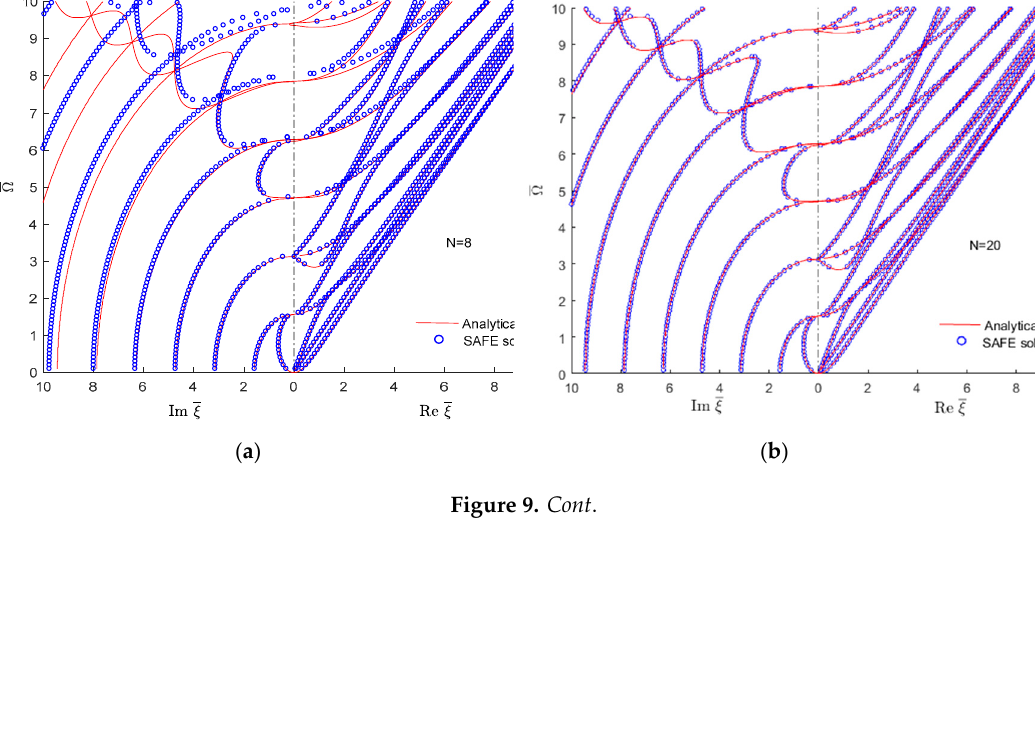
R² = 0.9786 ( c ) Figure 9. Convergence of the SAFE method in a 1-mm isotropic aluminum alloy plate showing that 0.5% accuracy in the highest wavenumber-frequency pair can be obtained with N = 20 SAFE elements across the thickness. The SAFE plots are overlapped on top of the exact analytical plots: ( a ) for N = 8, divergence from exact analytical solution at the upper left corner of the wavenumber-frequency diagram; ( b ) for N = 20, the SAFE and analytical solutions overlap everywhere; ( c ) convergence plot showing the error falling below 0.5% as N increases from N = 18 to N = 20. The trend line is a high-R exponential fit. The next step is to understand the effect of various material properties on the wavenumber trajectories in the complex wavenumber-frequency domain. To achieve this aim, the isotropic material properties are modified gradually and examined is the effect of these gradual changes on the wavenumber trajectories. 5. Effect of Changing Material Properties In this section, the primary goal is to understand how wavenumber trajectories are modified by incremental changes in material properties. The material properties are changed gradually from isotropic to transversely isotropic materials. The aim is to eventually get to the CFRP material